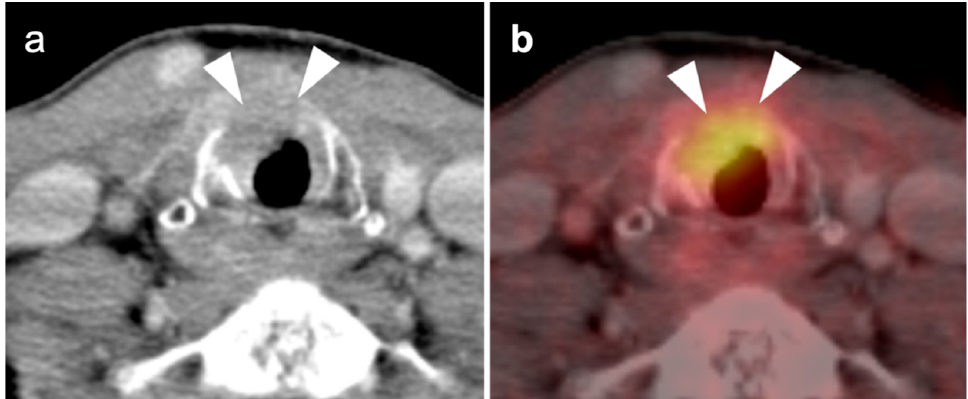
Figure 20. Squamous cell carcinoma of the subglottic larynx. Contrast ‐ enhanced axial CT ( a ) and axial FDG PET ‐ CT ( b ) images show a hypermetabolic soft tissue mass involving the anterior aspect of the subglottic larynx with anterior cricoid destruction (white arrowheads).